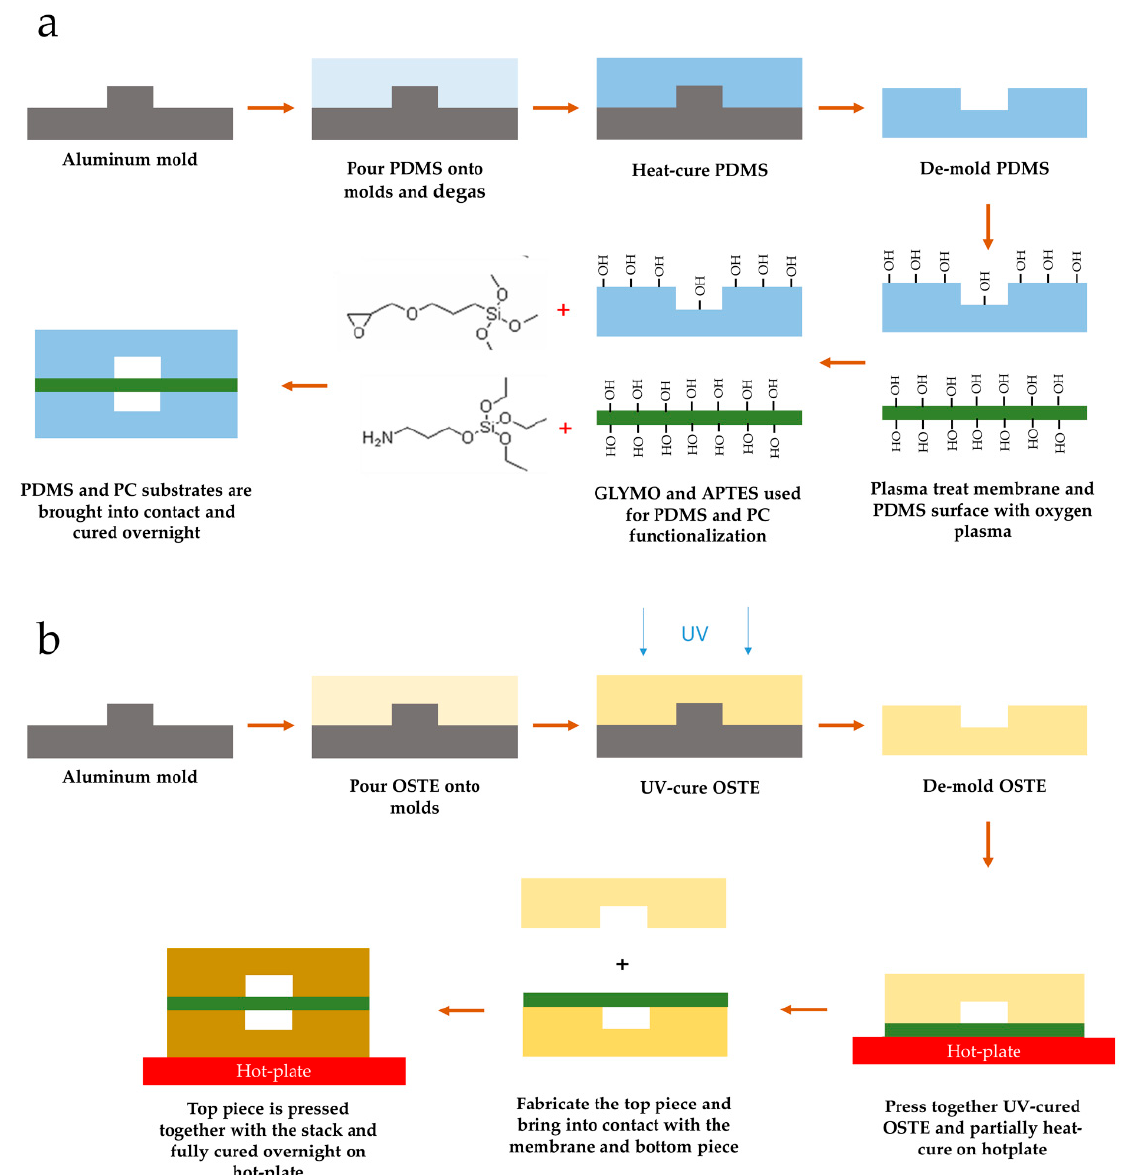
Figure 1. Lung on a chip (LOAC) device fabrication workflow. ( a ) Polydimethylsiloxane (PDMS) device fabrication workflow. The process is based on the epoxy–amine bonding process described previously [40]. Amine functionality was assigned to polycarbonate (PC) membrane to enhance extracellular matrix (ECM) adhesion to the membrane. ( b ) Off- stoichiometry thiol–ene (OSTE) device fabrication workflow. To retain membrane flatness during the assembly process, the bottom piece was pre-bonded and under-cured to the membrane first before bonding the top piece and fully curing the